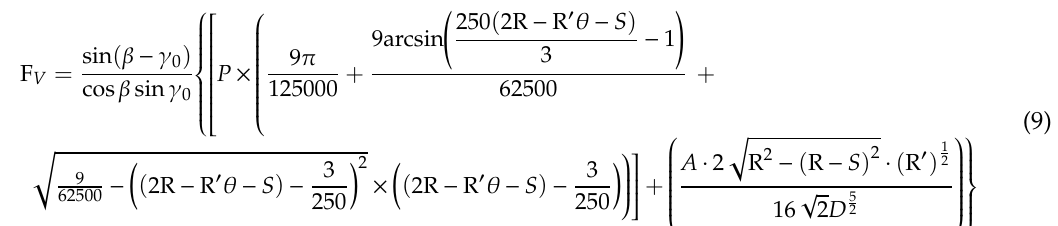
Figure 14. The 60° rake angle of the blade corresponded to the cutting force F H and F V.